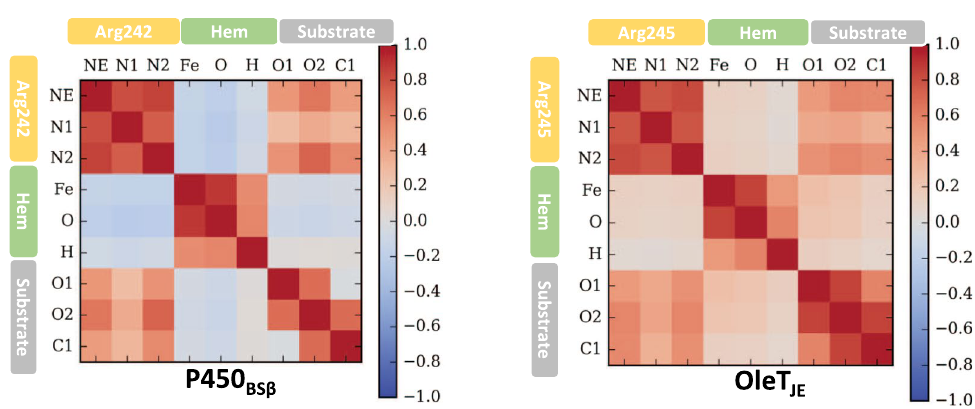
Figure 5. Dynamic cross-correlation analysis indicates substrate correlation with the Arginine residue. The H-bonding nitrogen atoms in Arg242/245, the carboxylate atoms on the substrate and the iron-hydroxo atoms on compound II are considered. Positively correlated motions are shown in red while bluish regions indicate no